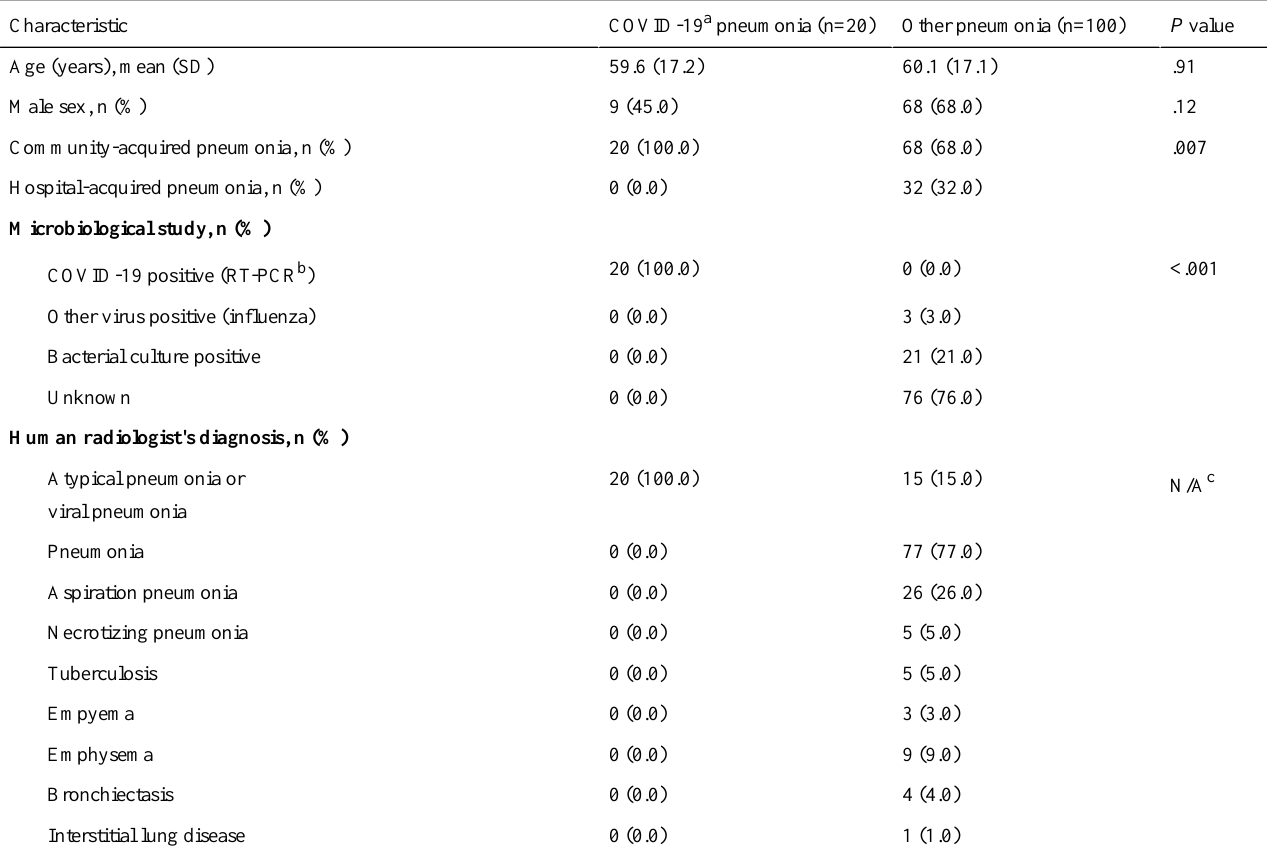
Table 2. Demographic data of patients with COVID-19 and other